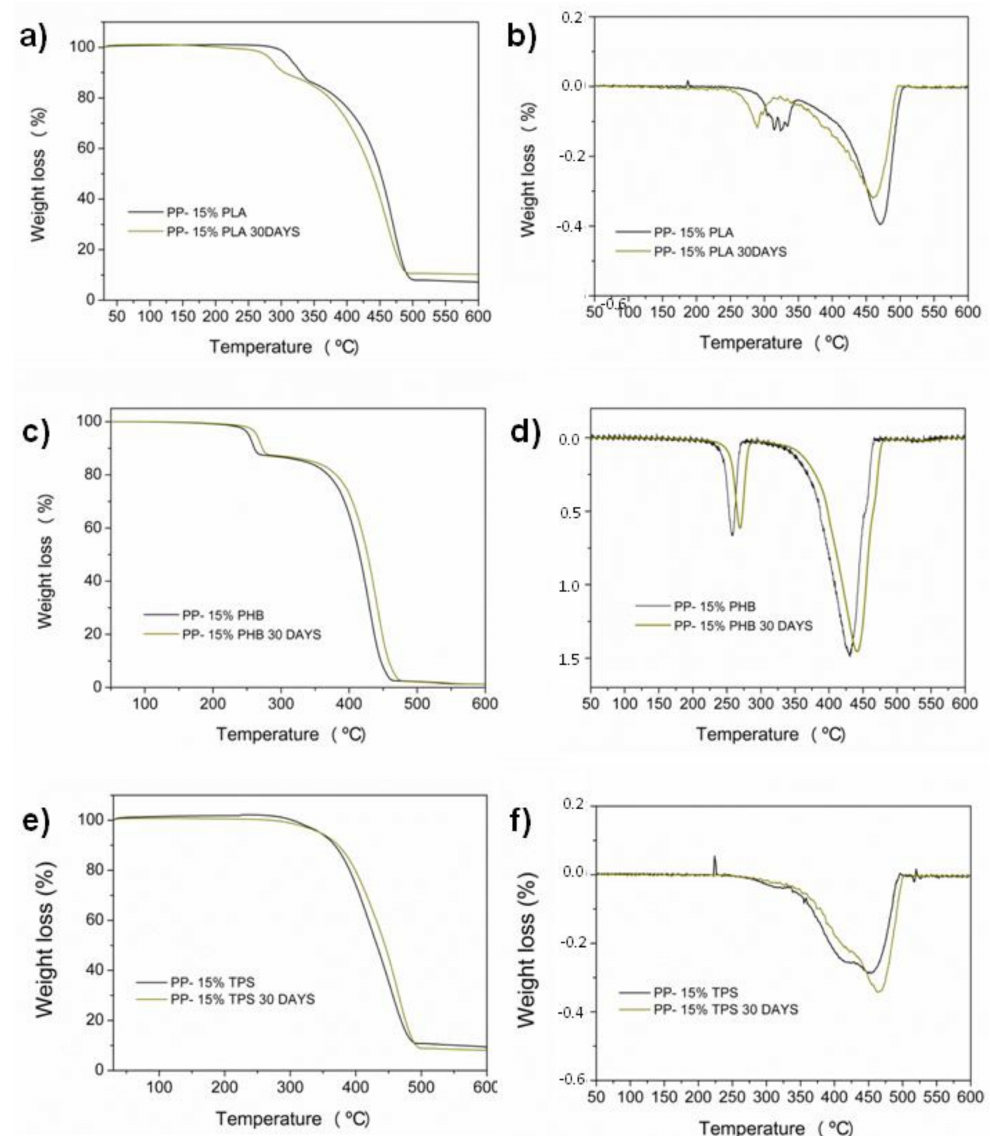
Figure 10. TGA ( a , c , e ) and DTG ( b , d , f ) thermograms of PP- biodegradable blends before and after 30 days exposed to a composting